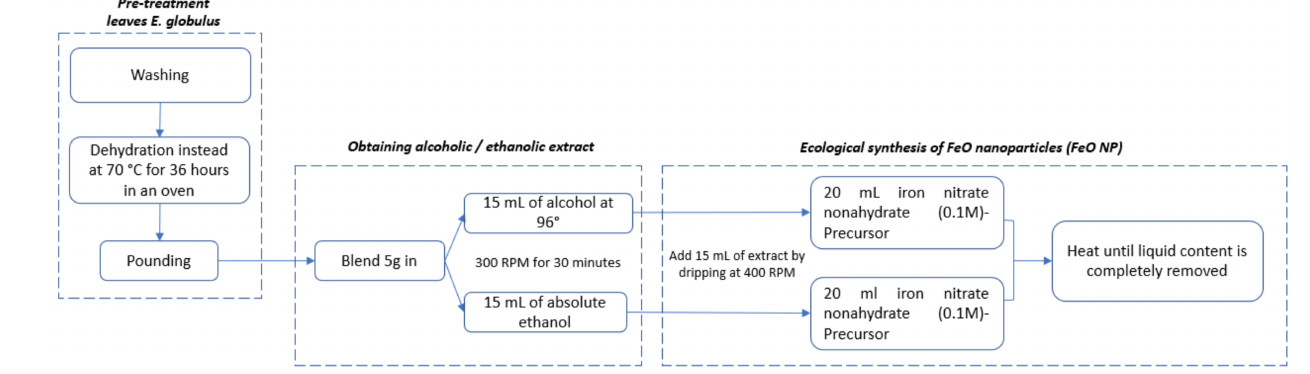
Figure 1. Scheme of the green synthesis protocol of iron oxide nanoparticles (FeO NPs), using extracts of E. globulus